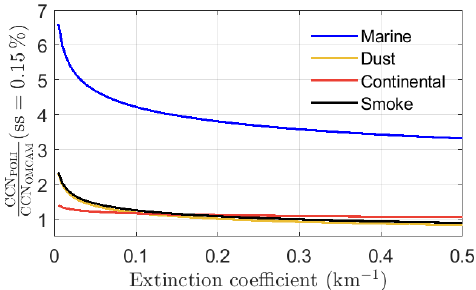
Figure 5. Ratio of CCN ss = 0 . 15 estimated from POLIPHON and OMCAM algorithms for varying extinction coefficient for marine, dust, continental, and smoke aerosol